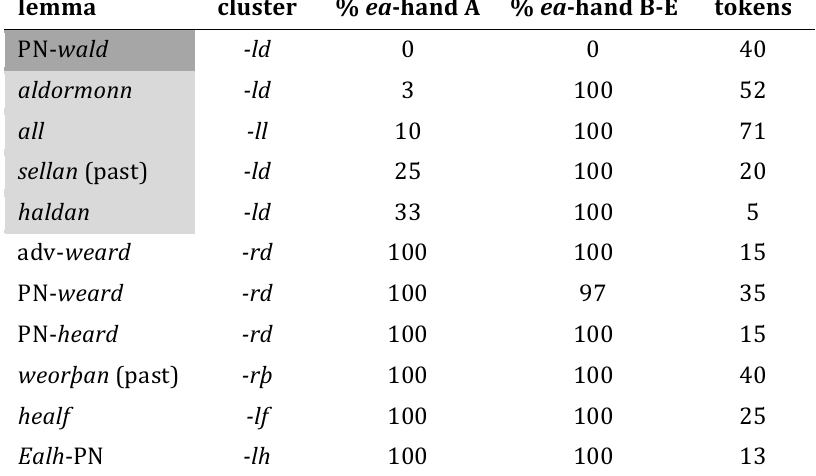
Table 5 : Lemmas with PGmc * a before - r / l C without i- mutation in the Parker Chronicle , attested at least two times in both the early hand and later hands. PN = personal name, adv. =